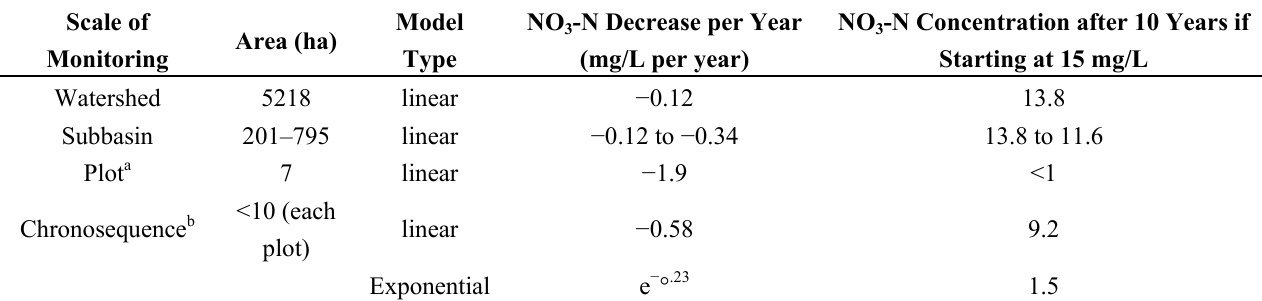
Table 2. Comparison of nitrate concentration reductions measured at different scales. Note that concentration decreases are greater at smaller